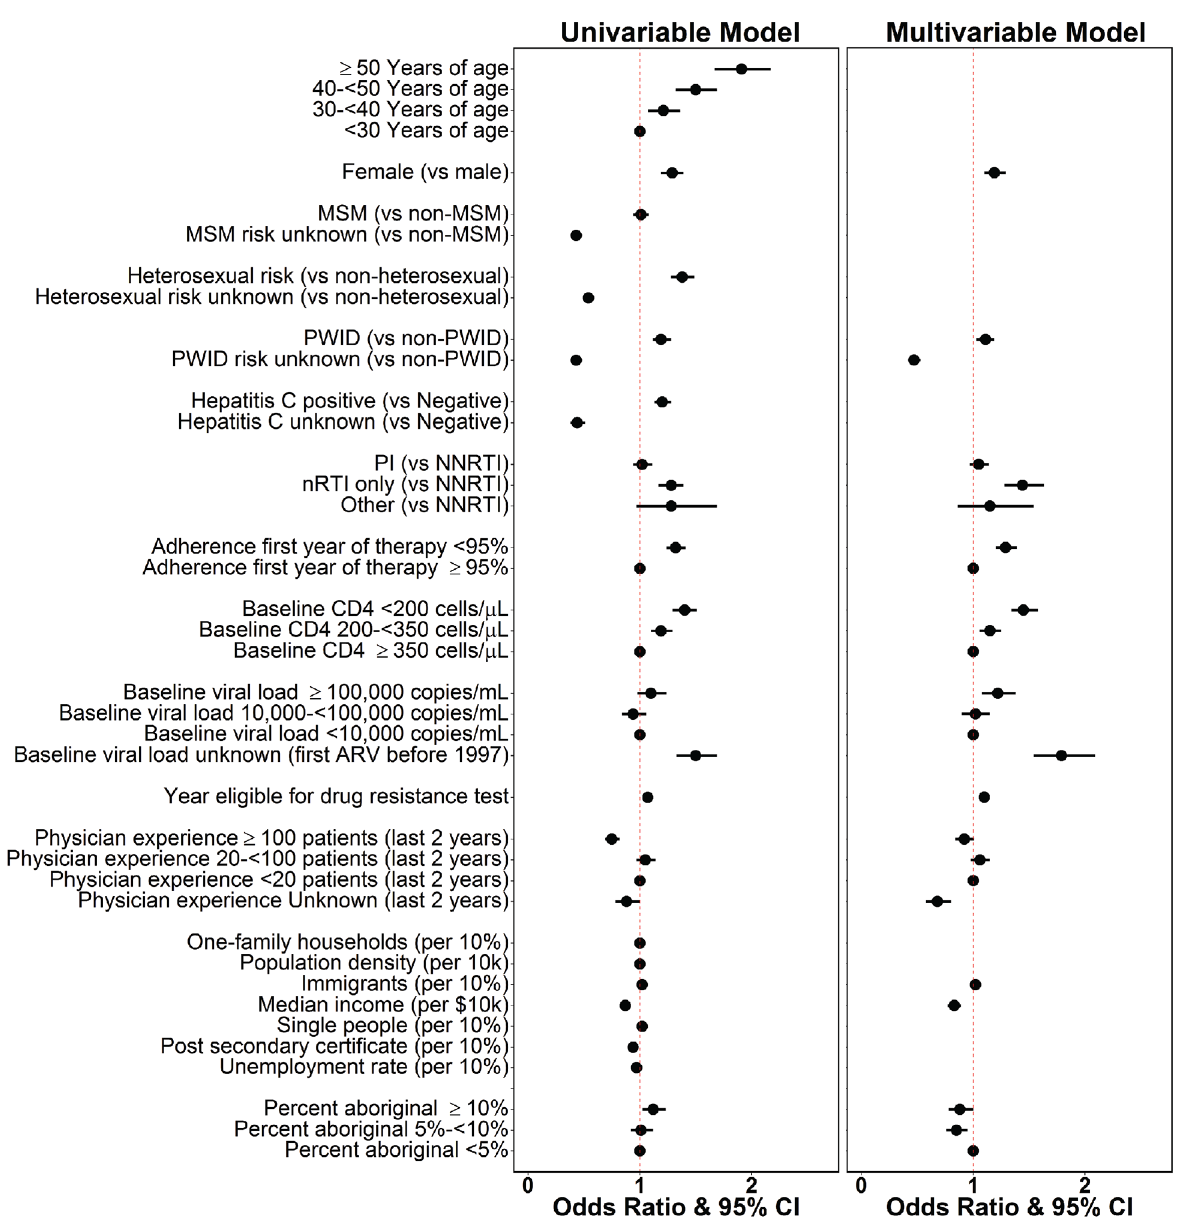
Fig 1. Odds ratio and 95% confidence intervals assessingthe odds of accessing drug resistance testing, by model. Odds Ratios do not exist for covariatesnot selectedunder the multivariablemodel (see Methods).